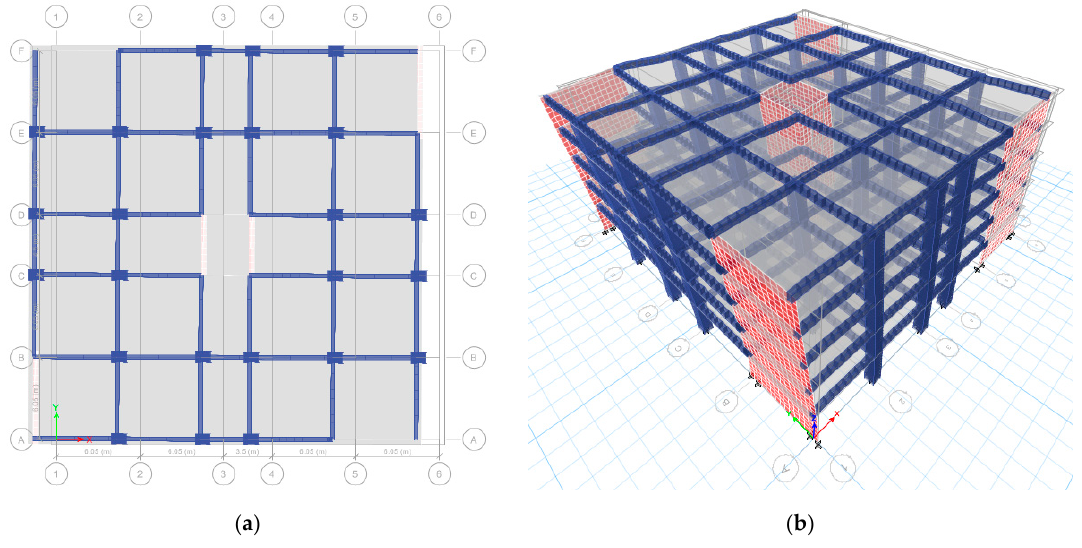
Figure 16. The 1st mode shape for T 1 = 0.239 s after the reducing of the torsion: ( a ) plane view and ( b ) 3D view.